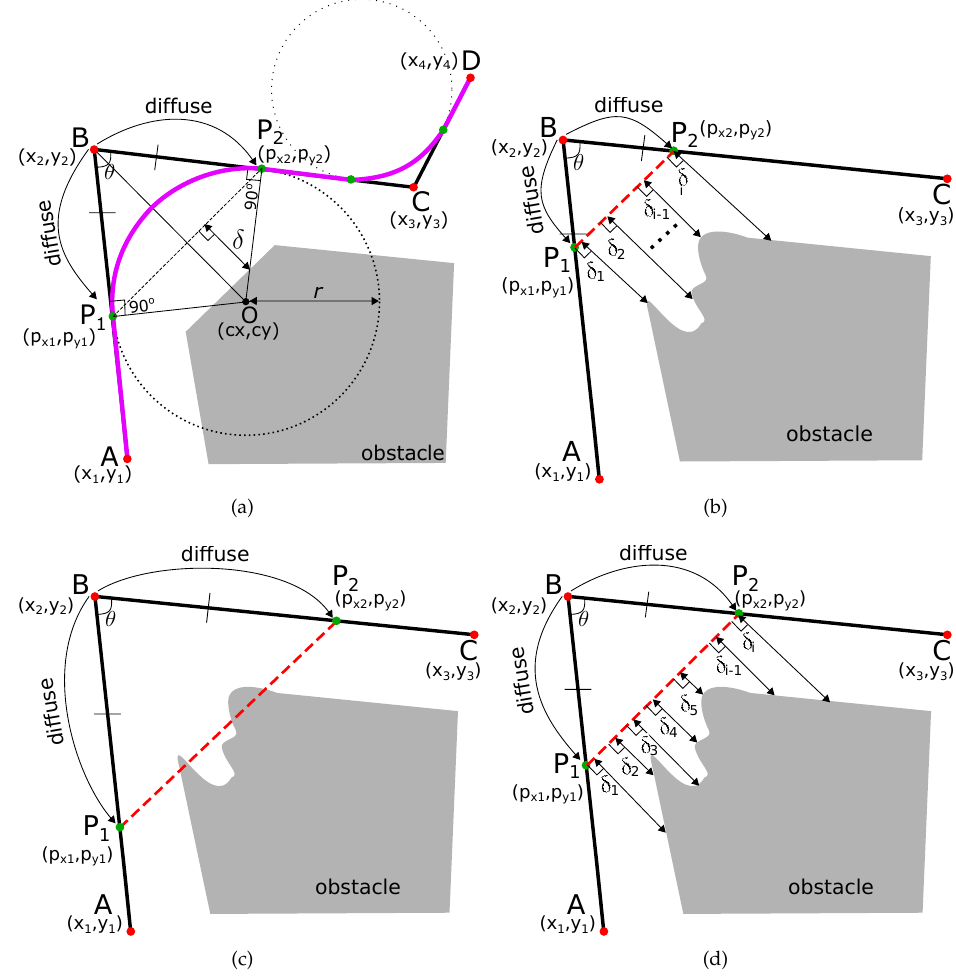
Figure 1. Diffusion in ITC (Infused Tangential Curves) based smoothing. ( a ) ITC curve ¯ P 1 P 2 is induced in the original path and tangential at points P 1 and P 2 ; ( b ) under diffusion of point B; ( c ) over diffusion of point B; ( d ) appropriate diffusion of point